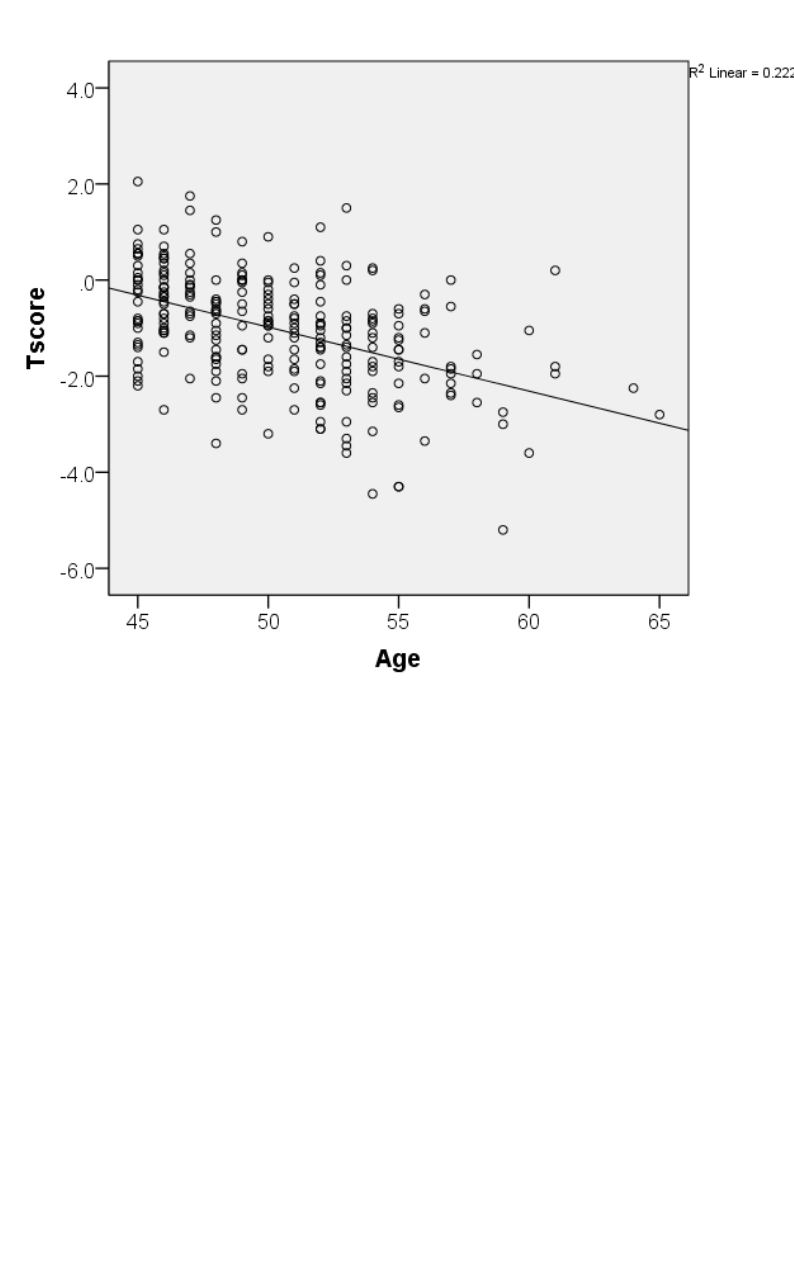
Figure 2. Correlation between age and speed of